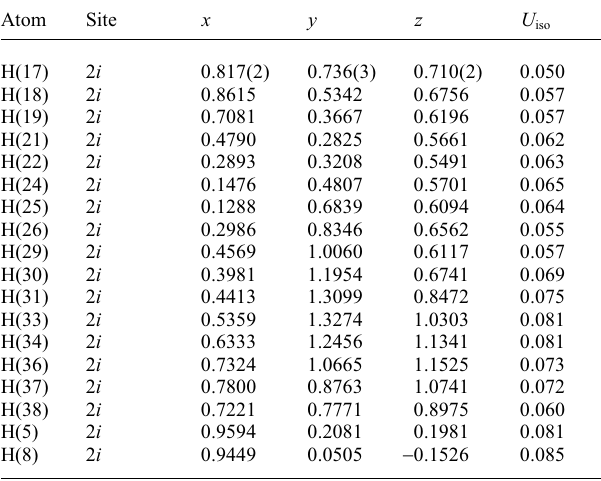
Table 2. Atomic coordinates and displacement parameters (in Å 2 )